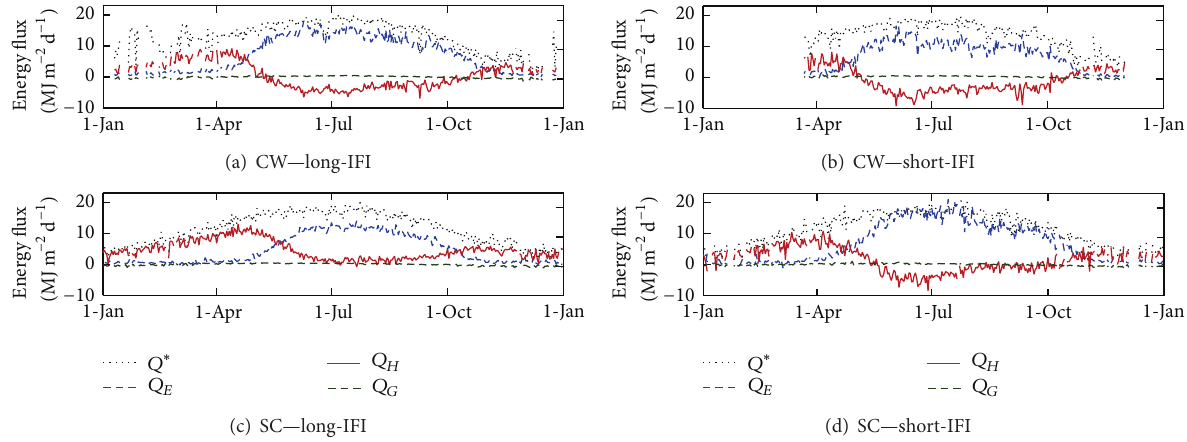
Figure 6: Daily total energy fluxes, averaged across all